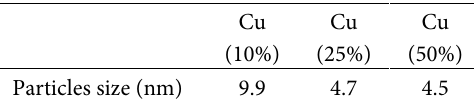
Table 2. Particle Size Variation with Different Percentages of Copper from XRD Analysis